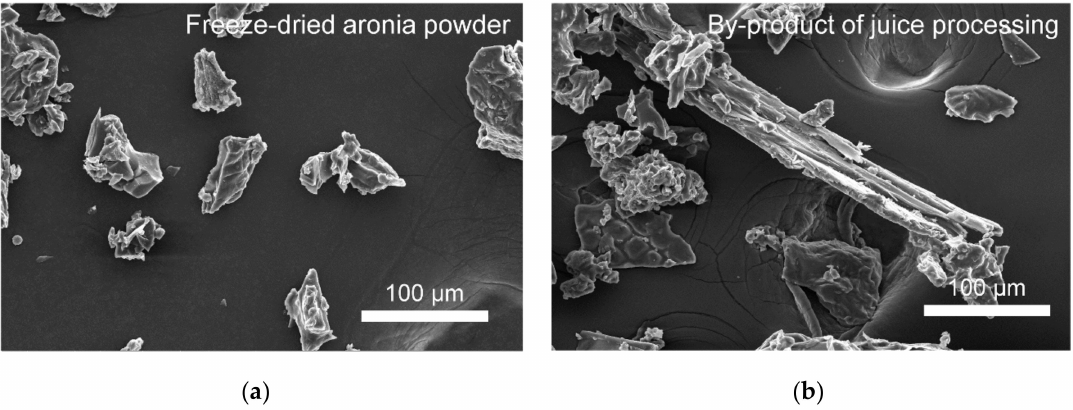
Figure 3. FE-SEM images of aronia freeze-dried powder ( a ) and aronia juice processing by-products ( b ).